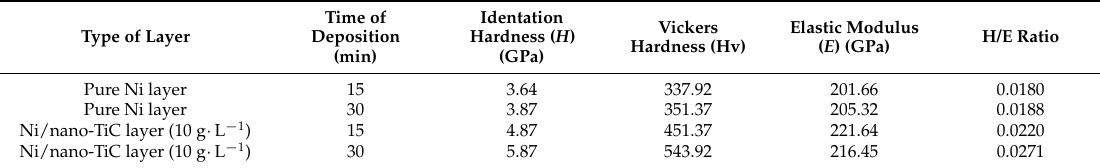
Table 3. Nanoidentation results as hardness, elastic modulus and H/E ratio for Ni/nano-TiC hybrid nanocomposite and pure Ni